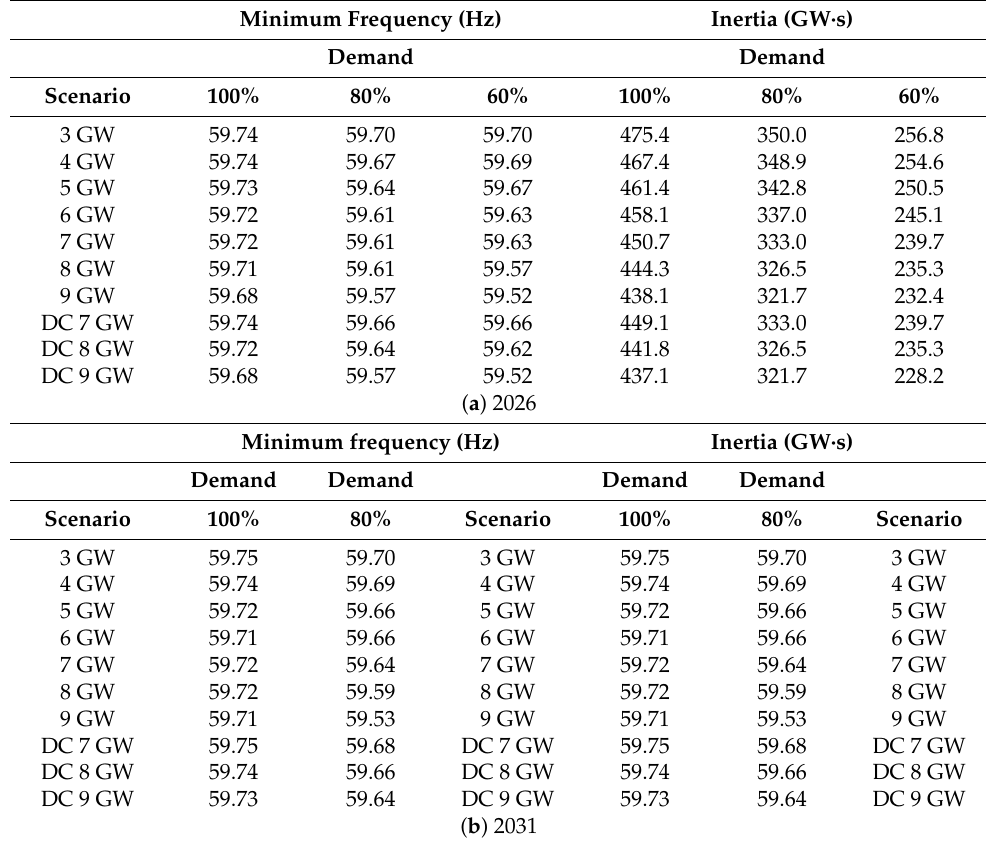
Table 11. The results for the frequency stability analysis by dropping a renewable energy capacity of 1